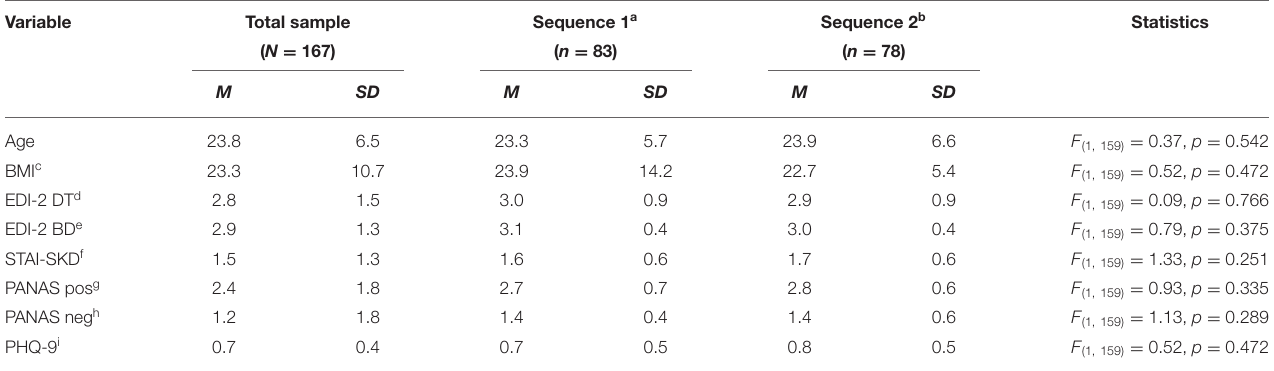
TABLE 1 | Means and standard deviations of demographic characteristics and trait-like measures. Variable